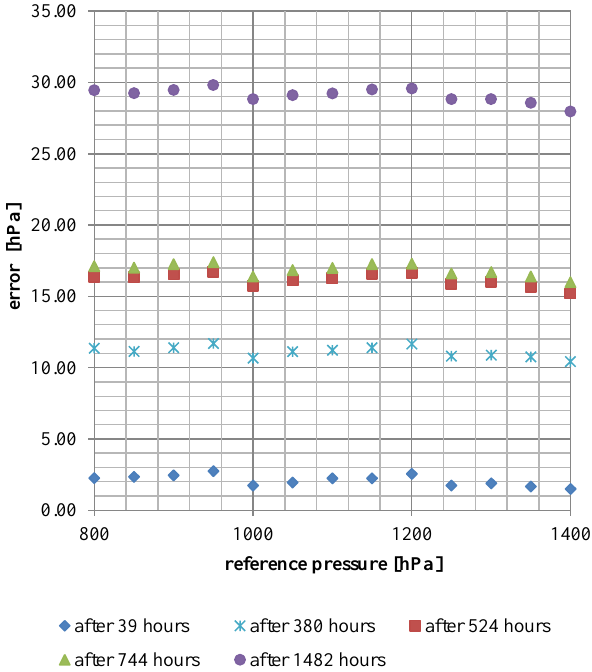
Figure 23. Error of the pressure curves after a different accelerated life test time at 60 ◦ C in saline solution (the measurements were recorded at 36 ◦ C).